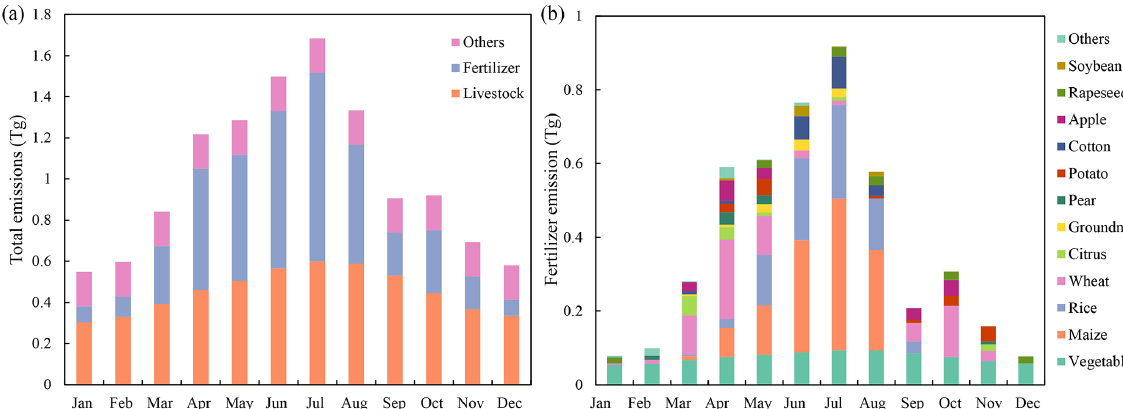
Figure 5. Monthly NH 3 emissions from (a) different sources and (b) different crops. Table 3. NH 3 emissions (Gg) from various sources in the different provinces in mainland